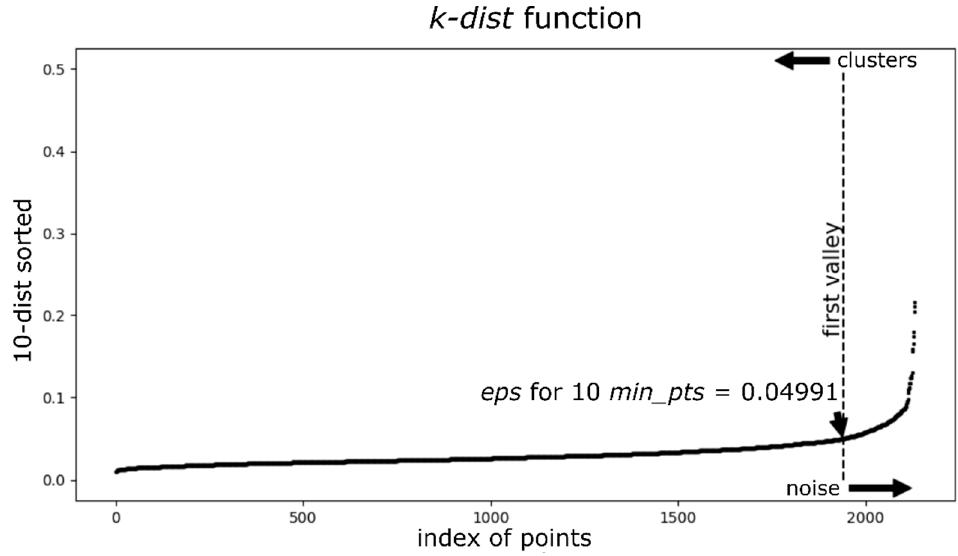
Figure 5. k ‐ dist function for k